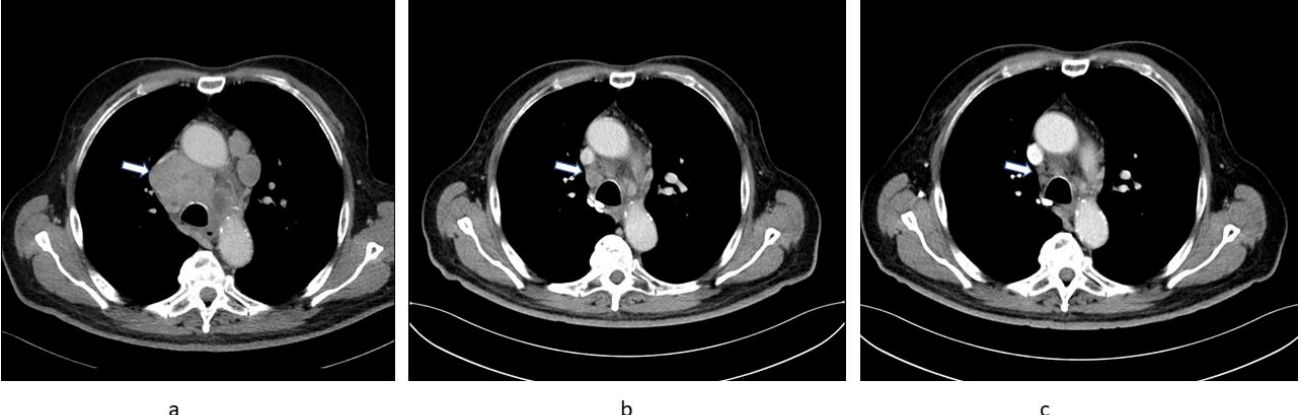
Figure 1. Sequential chest CT images of Patient 1 showing regression of substantial mediastinal lymphadenopathy